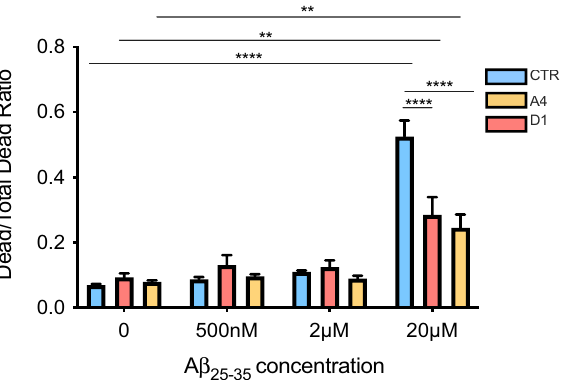
Figure 2. Exon 2 −/− neurons exhibit lower cell death rates when treated with Aβ 25–35 . CTR and exon 2 −/− neurons were treated with a one of three concentrations of Aβ 25–35 (500 nM, 2 μM or 20 μM). After 24 h of treatment, cell death induced by Aβ 25–35 was quantified. AAF-Glo reagent was added to cultures to measure protease activity released from apoptotic cells, giving a measurement of death induced by Aβ 25–35 treatment. Death was then induced in the remaining, live cells by addition of digitonin and AAF-Glo. Death was quantified again giving a measurement of total number of death cells in each culture, representing the total number of cells. For each condition, the Dead/Total Dead Ratio was calculated and compared. Before Aβ 25–35 treatment, the ratios of exon 2 −/− and CTR neurons were comparable (p > 0.9999 for all comparisons). 20 μM Aβ 25–35 significantly increased the Dead/Total Dead Ratios of both CTR and exon 2 −/− neurons (CTR; p < 0.0001****, A4; p = 0.0200* and D1; p = 0.0254*. The percentage increase in number ratios for each cell line: CTR: 658.67% increase, A4: 208.24% increase and D1: 209.61% increase). 500 nM and 2 μM Aβ 25–35 treatments did not induce significant cell death in any culture. Dead/Total Dead Ratios of 20 μM Aβ 25–35 treated CTR cultures were significantly higher than the Ratios demonstrated in exon 2 −/− cultures (20 μM Aβ 25–35 CTR vs A4: p < 0.0001**** and 20 μM Aβ 25–35 CTR vs D1: p < 0.0001****) but were similar between the exon 2 −/− cultures (A4 vs D1: p = 0.9952). This reflects less cell death quantified in exon 2 −/− cultures than in CTR neurons. Dead/ Total Dead Ratios are reported as mean ± SEM and Two-Way ANOVAs were performed for all concentrations (*p < 0.05, **p < 0.01, ***p < 0.001 and ****p < 0.0001). Mean values were calculated from samples collected from three independent differentiations of neurons (n = 3), of which each contained 6 replicant